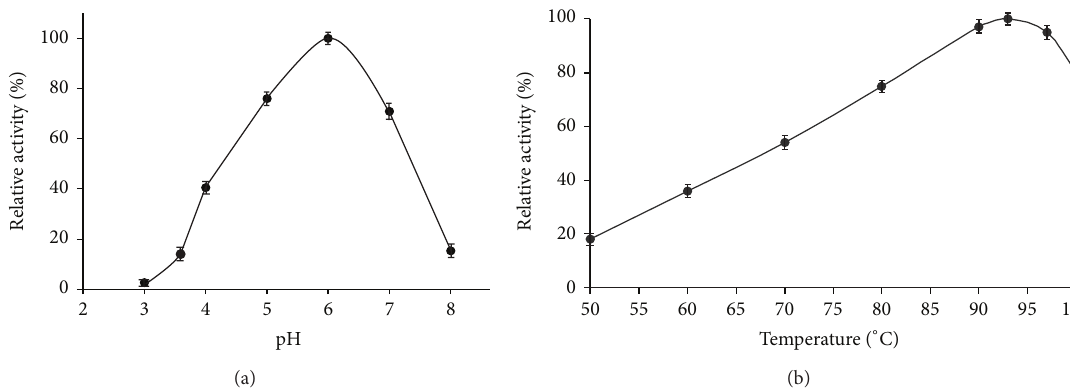
Figure 2: Effects of pH (a) and temperature (b) on the 𝛽 -galactosidase activity of recombinant Asac 1390. Data represent the means of three experiments and error bars represent standard deviation.